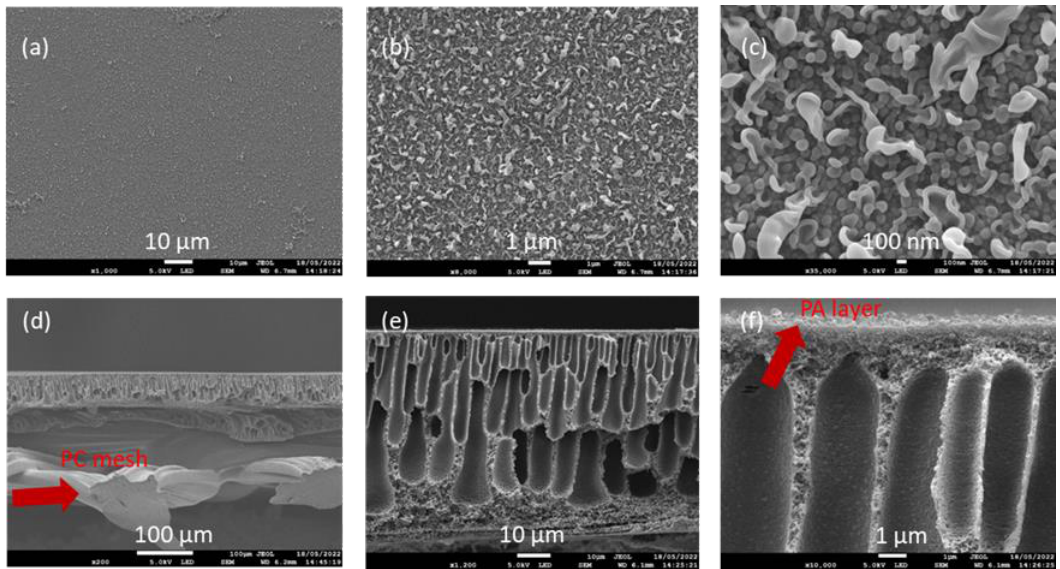
Figure 7. FESEM images of the reinforced membranes after TFC PA layer coating. ( a – c ) Top surface of the membrane depicting the PA layer coating, ( d ) membrane cross-section images showing the reinforcing permeate carrier material, ( e ) UF support layer with finger-like macro voids, and ( f ) zoomed-in image of the UF support layer with the PA layer. Table 2. Effect of pre-wetting on the RO flux and salt rejection of membrane, using different wetting agents. The RO testing was performed using 2000 mg/L NaCl solution at 15 bar pressure.